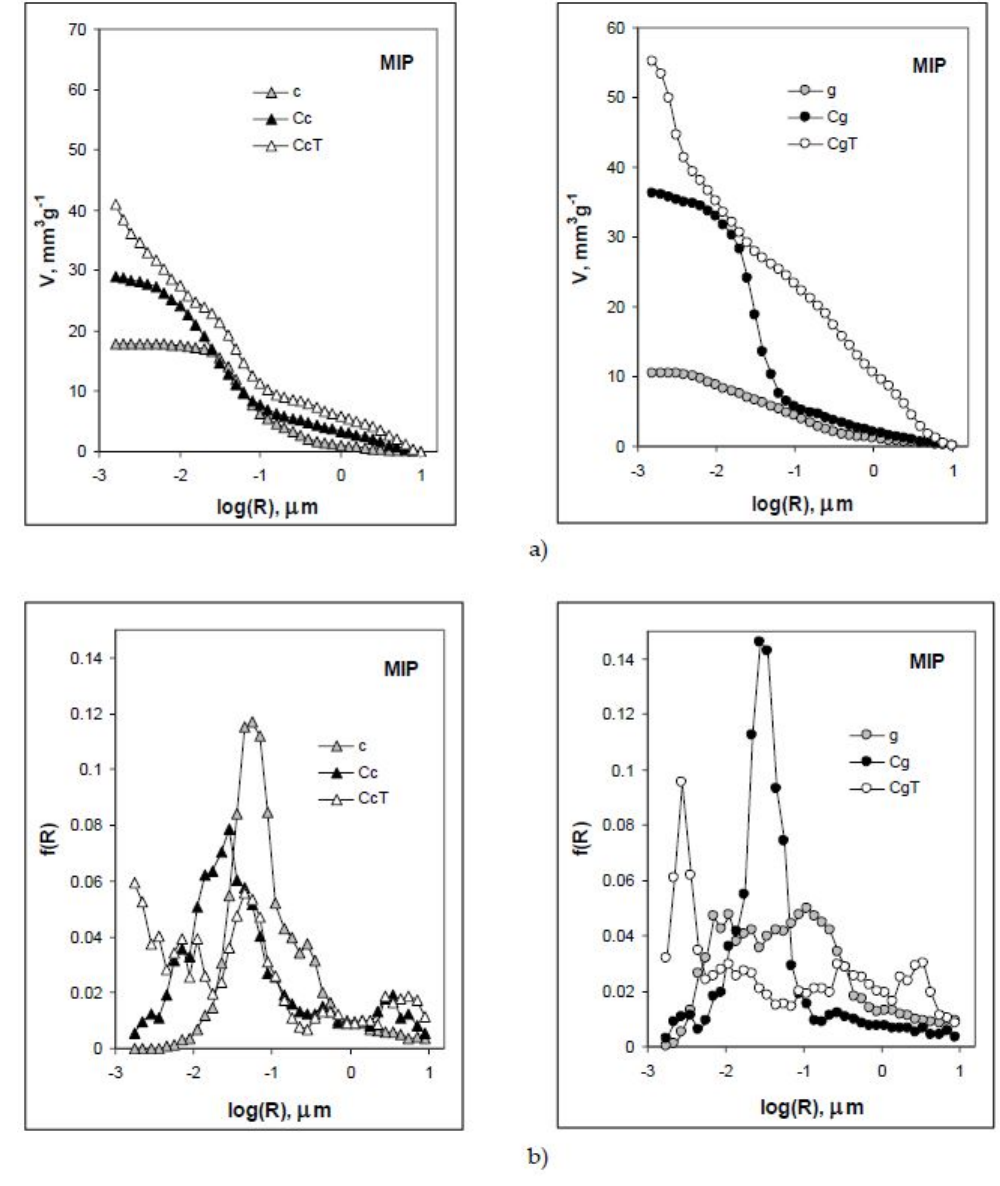
Figure 2. Mercury intrusion (MIP) pore volume vs. pore throat radius curves ( a ) and pore throat size